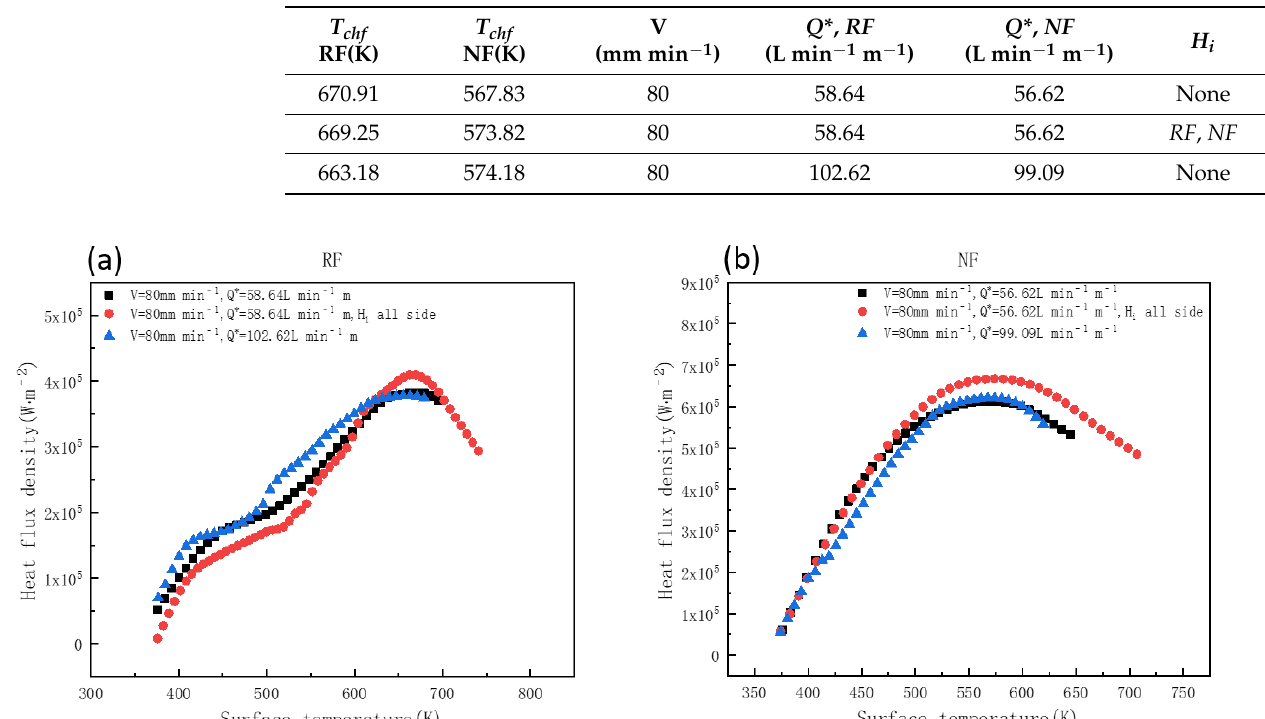
Table 3. The value of T chf during DC casting temperature-measurement test.